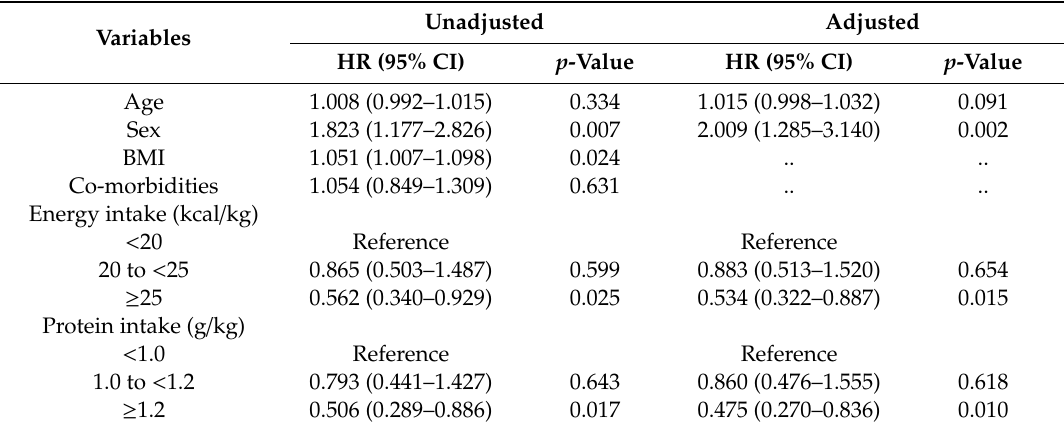
Table 3. Cox regression analysis for 28-day mortality in total study